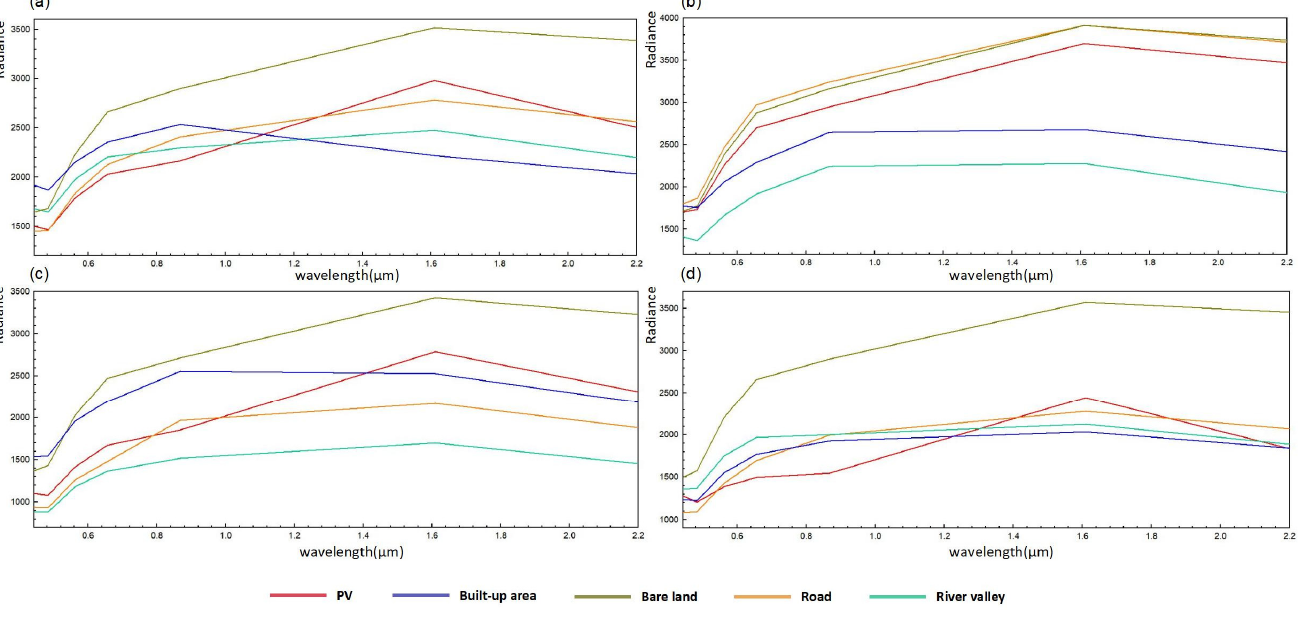
August, and ( d ) and December.